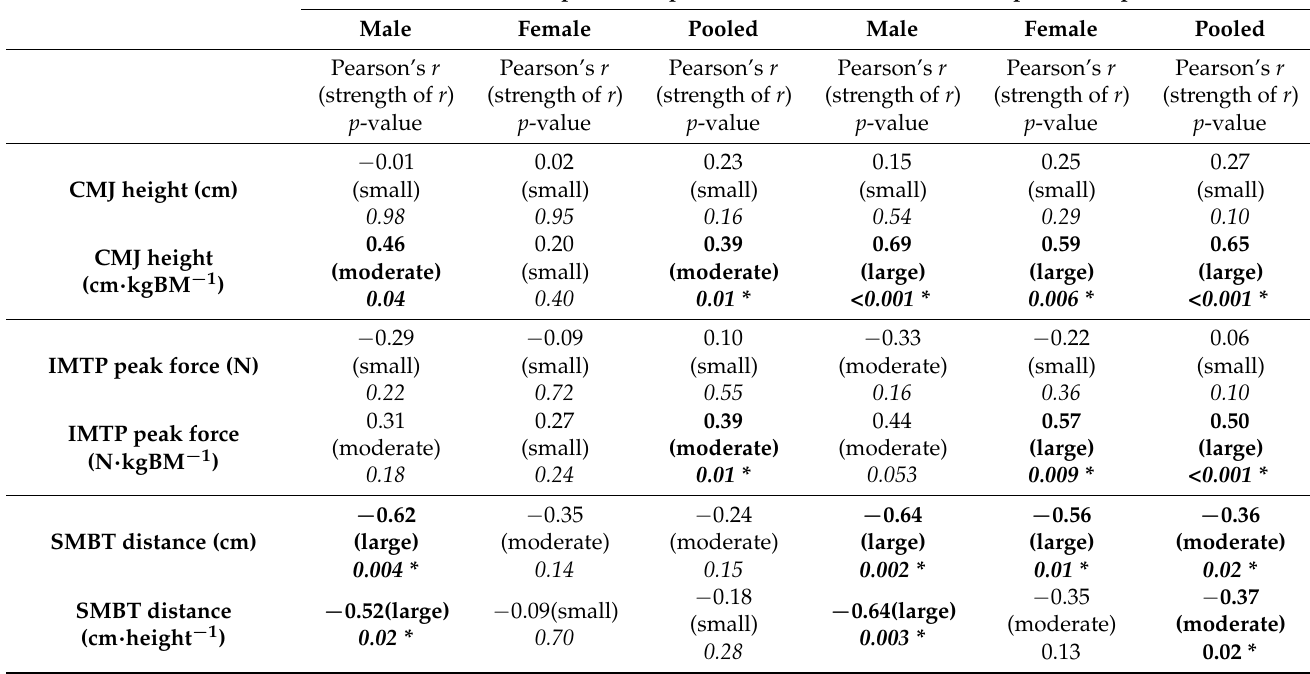
Table 5. Part II (validity). Correlation analysis between the number of burpees completed in the 3-min burpee test (or 3-MBT) in absolute and relative (adjusted to BMI) value and physical fitness assessments in absolute and relative (to body mass (BM) or to height) in male ( n = 20) and female ( n = 20)